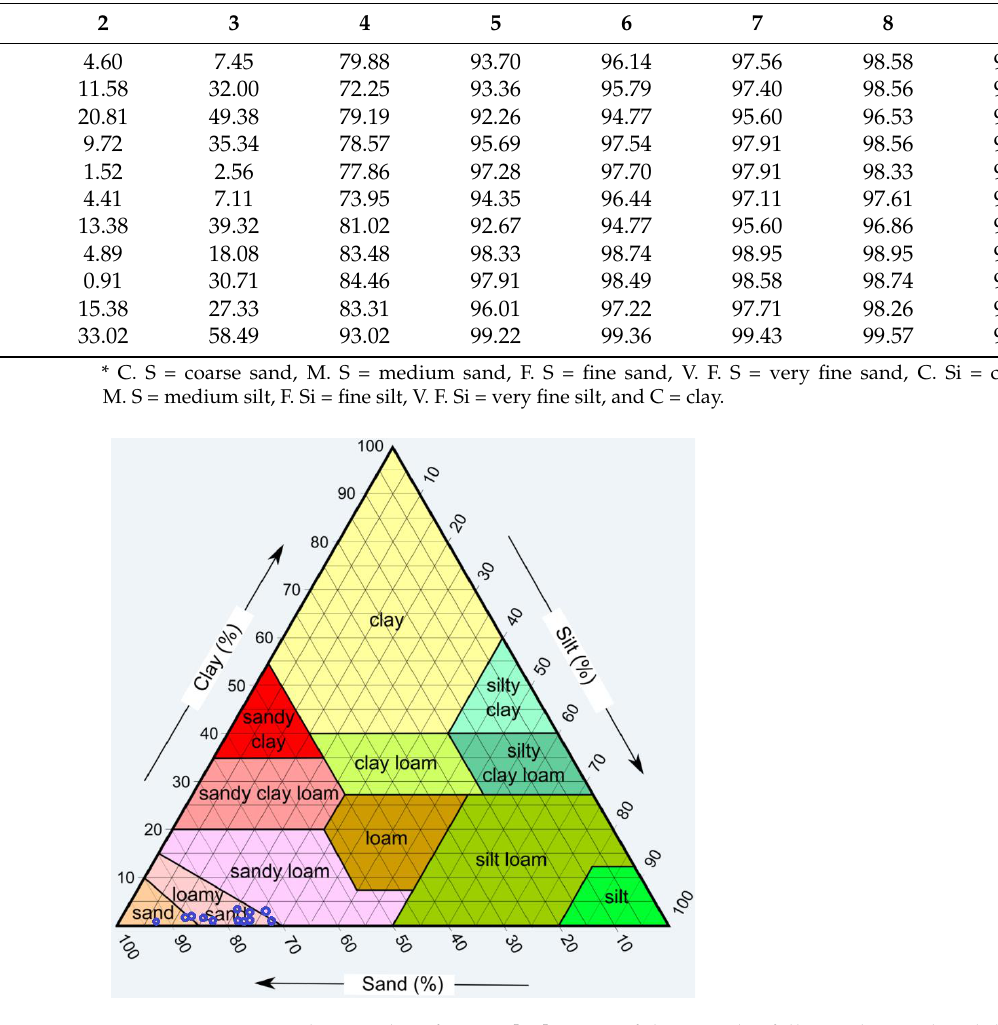
Figure 21. USDA sediment classification [23]. Most of the samples fall into the sand and the loamy sand ranges, mainly controlled by the silt percentage in the sample.